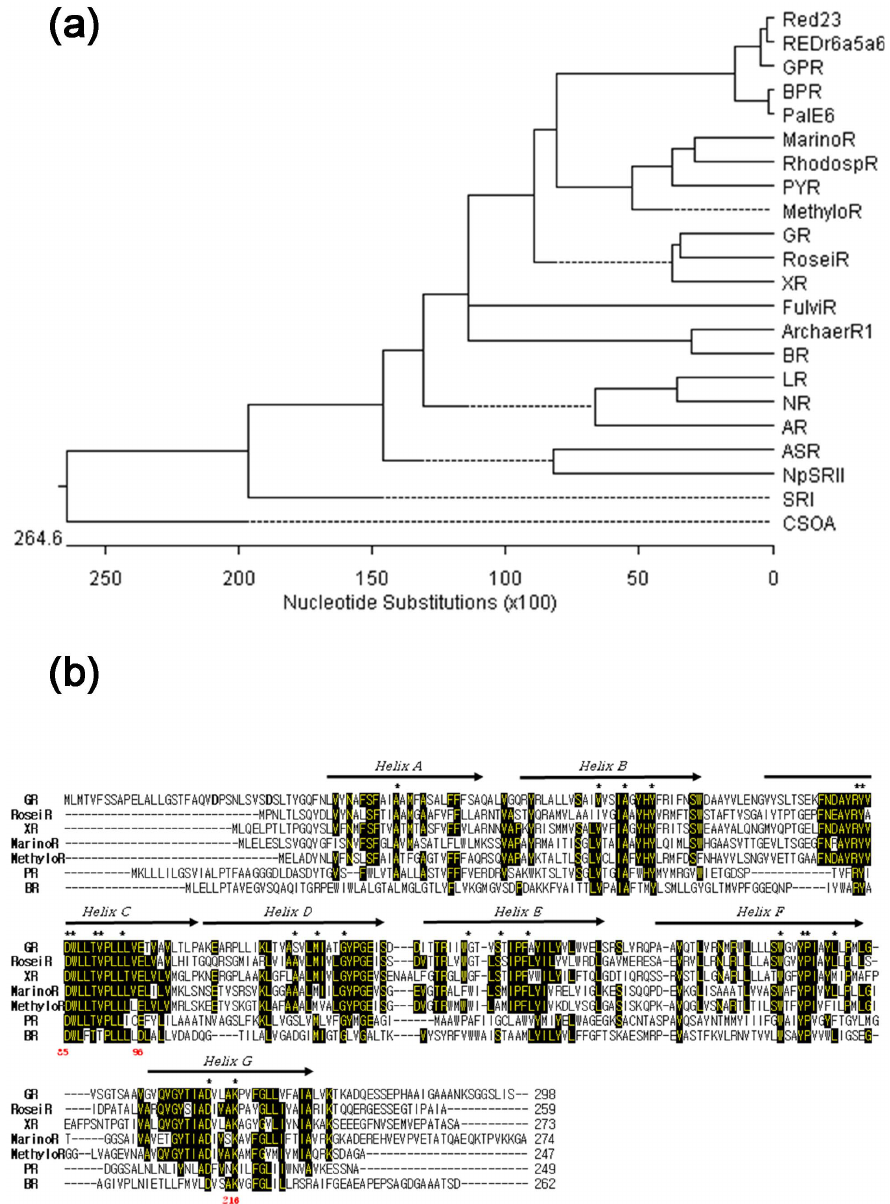
Figure 1. Pylogenetic tree and alignment. (a) Phylogenetic tree of 22 microbial opsin sequences, representing phylogenetic relationship between Gloeobacter rhodopsin and related proteins from archaea to algae. Analysis was conducted by ClustalW. A dotted line on a phenogram indicates a negative branch length, a common result of averaging by the DNA STAR software. GR: Gloeobacter rhodopsin (accession number; NP_923144). Red23 and REDr6a5a2 were collected from Red Sea. GRP/BPR: green/blue-absorbing PRs. PalE6 was collected from Antarctic ocean. RhodospR: rhodopsin from Rhodospirillales sp . XR: Xanthorhodopsin from Salinibacter ruber . FulviR: rhodopsin from Fulvimarina . ArchaerR1: Archaerhodopsin 1. PYR: rhodopsin from Pyrocystis lunula . BR: Halobacterium salinarum bacteriorhodopsin. RoseiR: rhodopsin from Roseiflexus sp .MarinoR: rhodopsin from Marinobacter . MethyloR: rhodopsin from Methylophilales .LR: rhodopsin from Leptosphaeria maculans . NR: rhodopsin from Neurospora crassa . AR: rhodopsin from Acetabularia acetabulum . SRI: H. salinarum sensory rhodopsin I. NpSRII: Natronomonas pharaonis sensory rhodopsin II. ASR: sensory rhodopsin from Anabaena (Nostoc) sp. CSOA: Chlamydomonas reinhardtii sensory rhodopsin A. (b) Alignment of the sequences of GR, XR, PR, RoseiR, MarinoR, MethyloR and BR. GR contains the functionally important residues for proton transport, including homologues of Arg82, Asp85, Trp86, Asp96, Trp182, Tyr185, Asp212, and Lys216, with some of the numbering and helical segments (marked by arrows) for BR. There are 22 residues (marked with black boxes) common to all seven proteins (in one case, Asp/Glu substitutions). The Asp121 (Asp85 in BR) should be the proton acceptor of the retinal Schiff base. The Glu132 (Asp96 in BR) may be the proton donor.